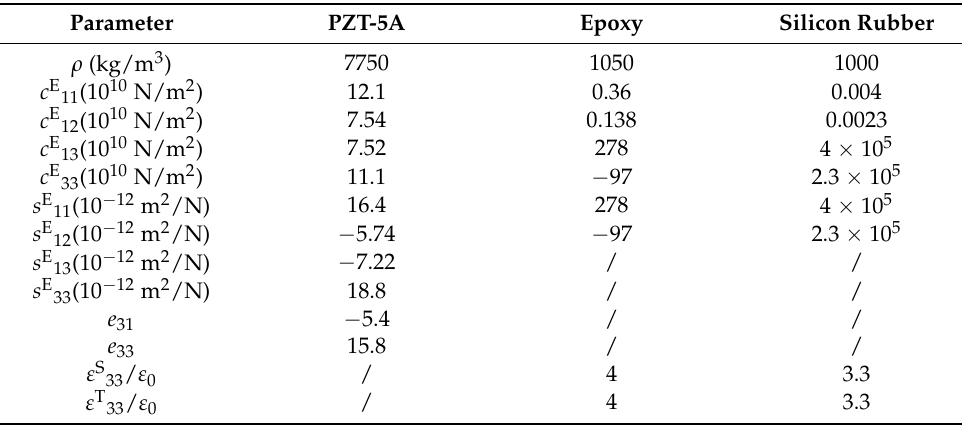
Table 1. Parameters of each component phase of